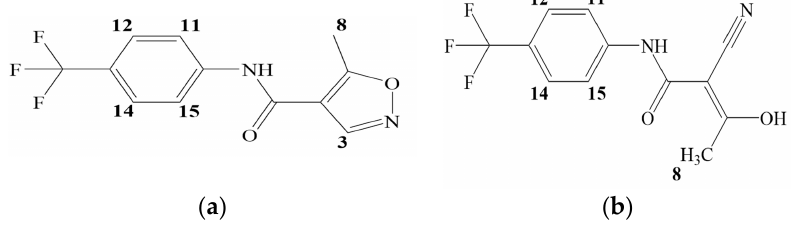
Figure 1. Structural formulas of leflunomide ( a ) and teriflunomide ( b ).